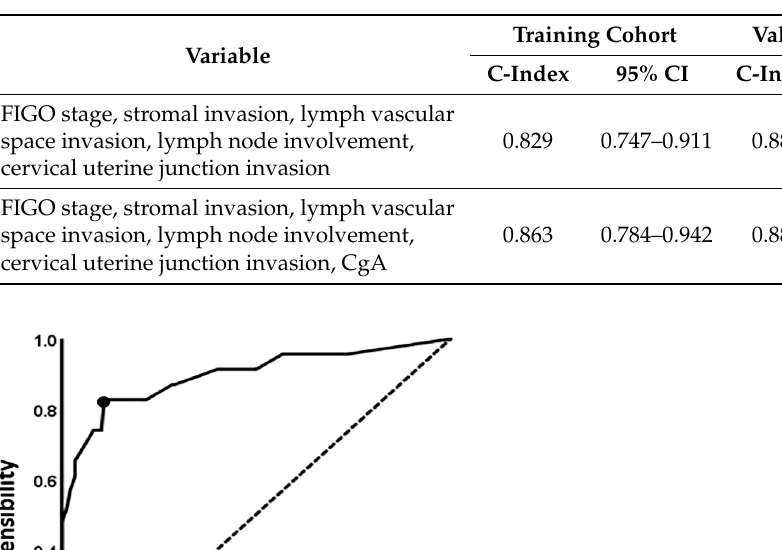
Table 3. The discriminatory power (C-index) of different parameters models in the training cohort and validation cohort.